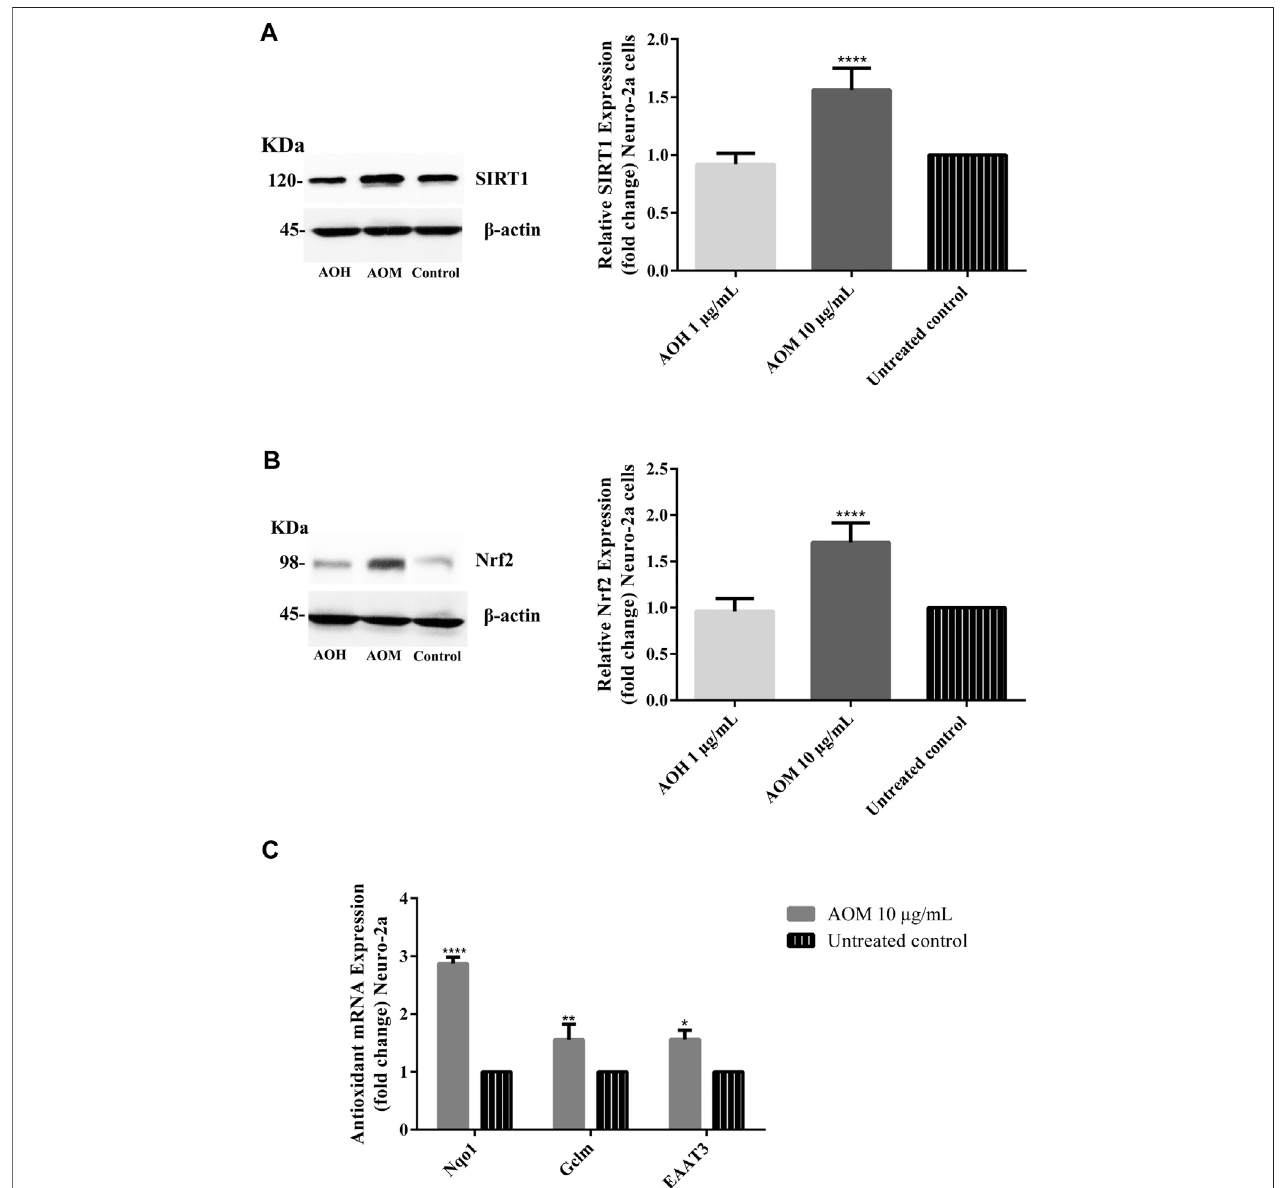
FIGURE 6 | Effect of AO extracts on SIRT1/Nrf2 signaling pathway. AO methanol extract treatment increased the SIRT1 (A) , Nrf2 expression (B) and antioxidant- relatedtargetgenes (C) inNeuro-2acellswhencomparedtotheuntreatedcontrol.SamplesweretreatedwithAOextractsfor48 h.Whole-celllysatesweresubjectedto western blot analysis of the SIRT1 and Nrf2 levels after AO extract treatment. β -actin was used as an endogenous loading control for western blot assay and internal control for RT-PCR assay. All data were normalized to endogenous control levels and the results are expressed as the means ± SEM of independent experiments ( n (cid:1) 3). * p < 0.05, ** p < 0.01, *** p < 0.001 and **** p < 0.0001, compared to the untreated